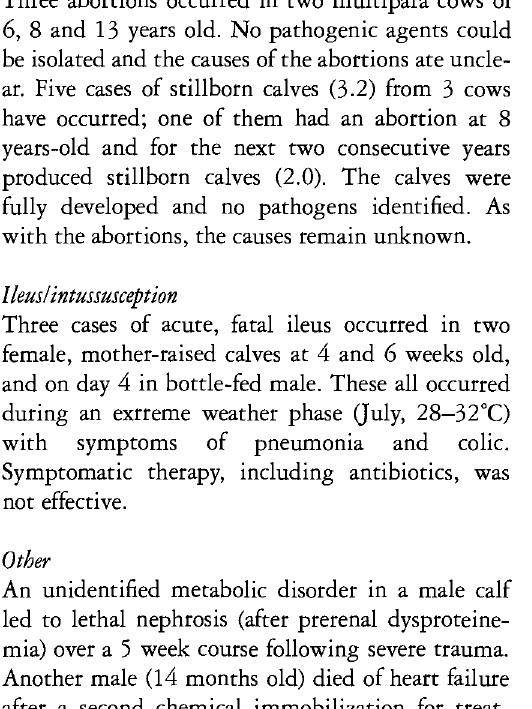
Table 2. Cause of death in young and adult muskoxen